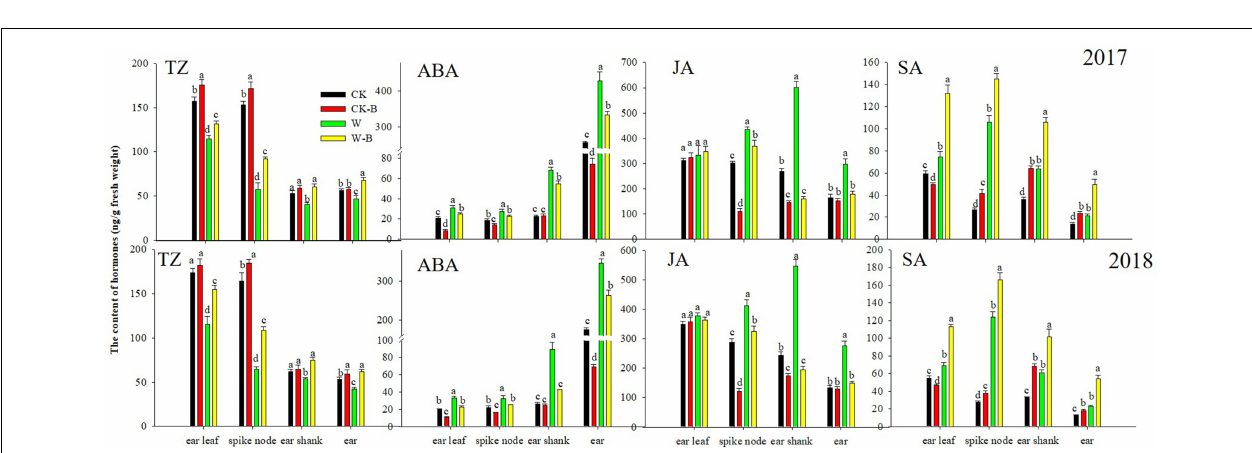
FIGURE 3 | The effects of 6-BA on the hormones metabolism of ears at the T1 stage. CK, control, no waterlogging stress; CK-B, spraying 6-BA on non-waterlogged plants; W, waterlogging; W-B, spraying 6-BA after waterlogging. Different letters on bars indicate the significant differences among treatments at P < 0.05 using the LSD test.